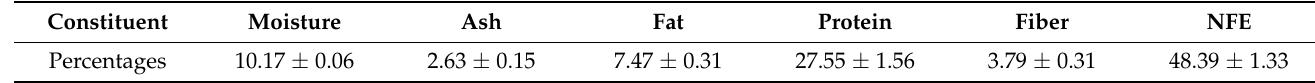
Table 1. Percentages of chemical compounds present in fenugreek